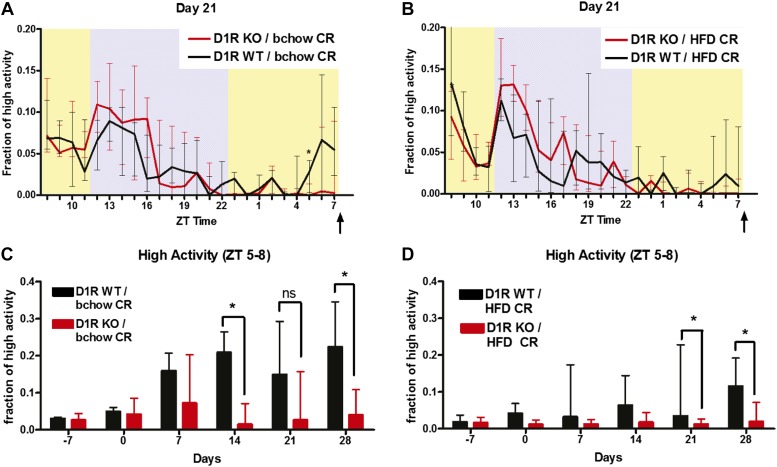
Higher fat content diet FAA studies in D1R KO mice.(A) Normalized high activity behavior of D1R KO (n = 6) and control (n = 8) mice on day 21 of 60% CR of breeder chow diet. (B) Normalized high activity behavior of D1R KO (n = 11) and control (n = 6) mice on day 21 of 60% CR on rodent high fat diet. (C) Normalized high activity in the 3 hr preceding scheduled meal time for mice on a diet of 60% CR breeder chow. (D) Normalized high activity in the 3 hr preceding scheduled meal time for mice on a diet of 60% CR high fat diet. The statistical test used was Mann–Whitney, where * indicates p < 0.05.